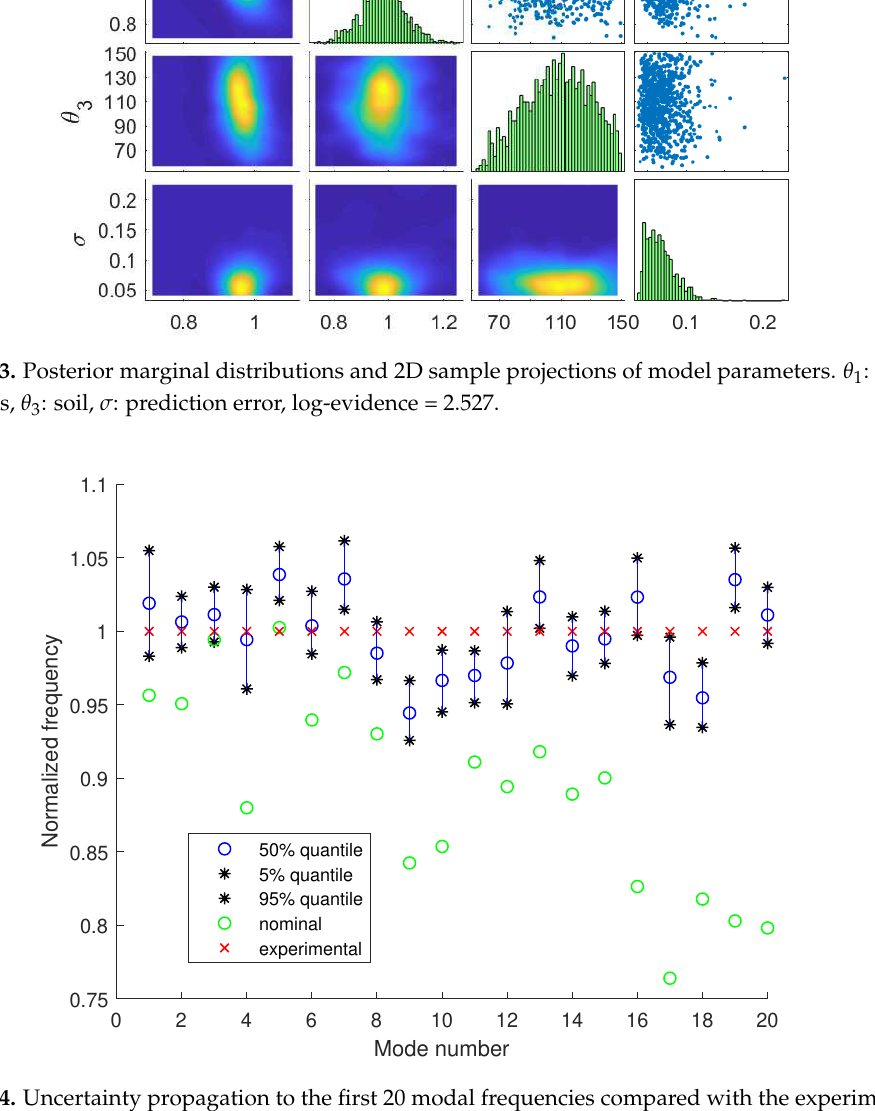
Figure 4. Uncertainty propagation to the first 20 modal frequencies compared with the experimental frequencies and nominal model